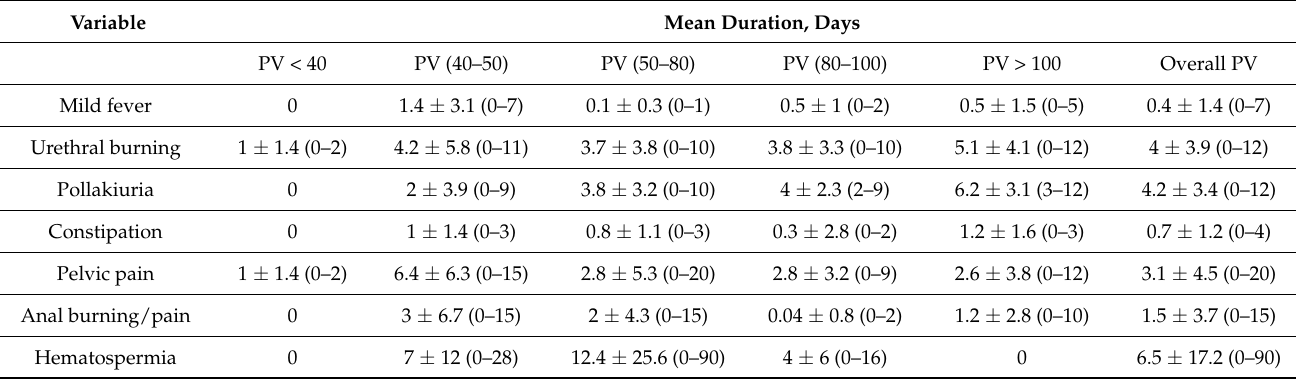
Table 3. Duration of post-embolization syndrome according to prostate volume.